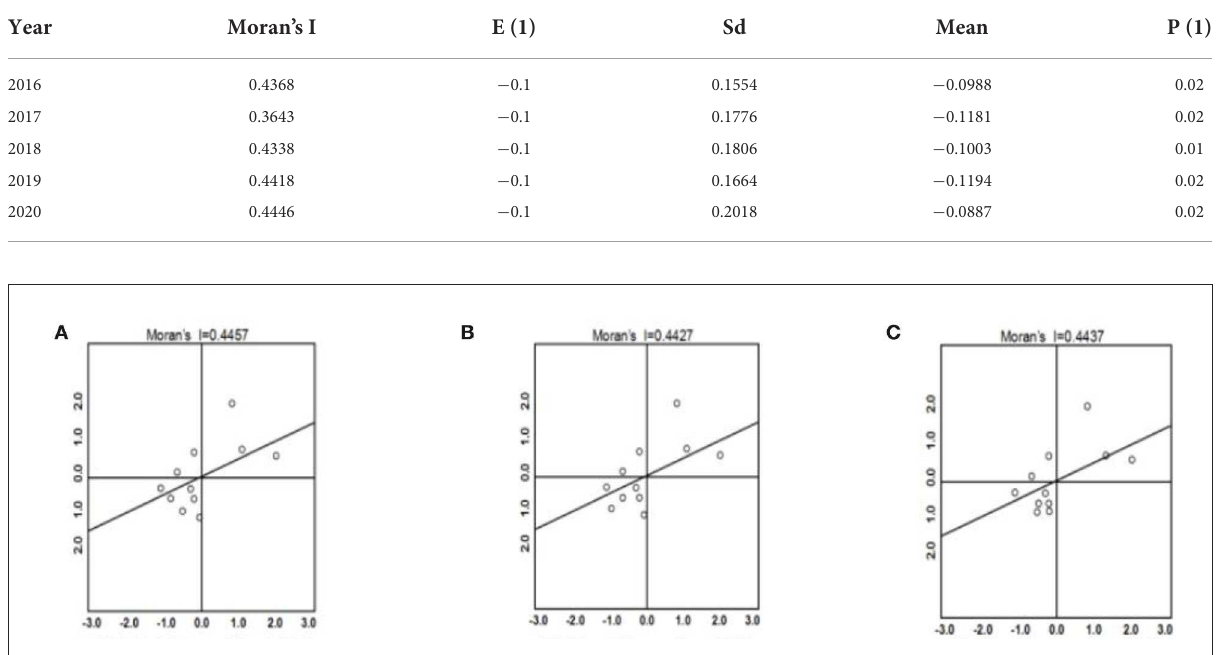
FIGURE1 (A–C) Moran’s I scatter plot for 2016, 2018, and